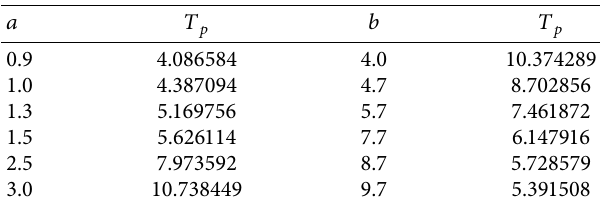
Figure 9: Homotopy evolution of (a, b) cycle 01 and (c) cycle 12 with different parameter values. Table 3: Periods T p of cycle 01 in the Rucklidge system for different parameter values.